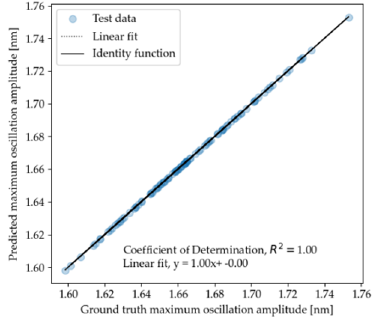
Figure 5. Performance of Model 3 on the test set specified in Section 2.3.3.